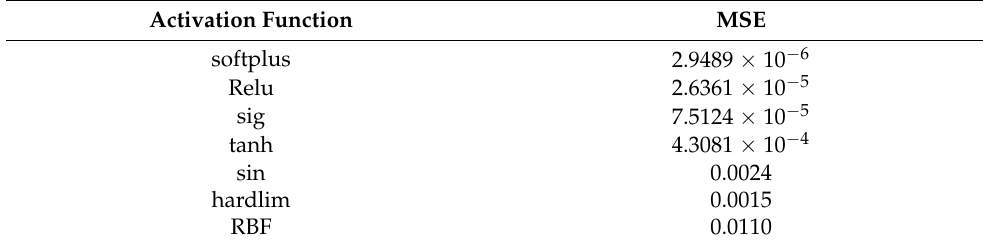
Table 2. The influence of different activation functions in the hidden layer on the predictive accuracy of the ELM model.